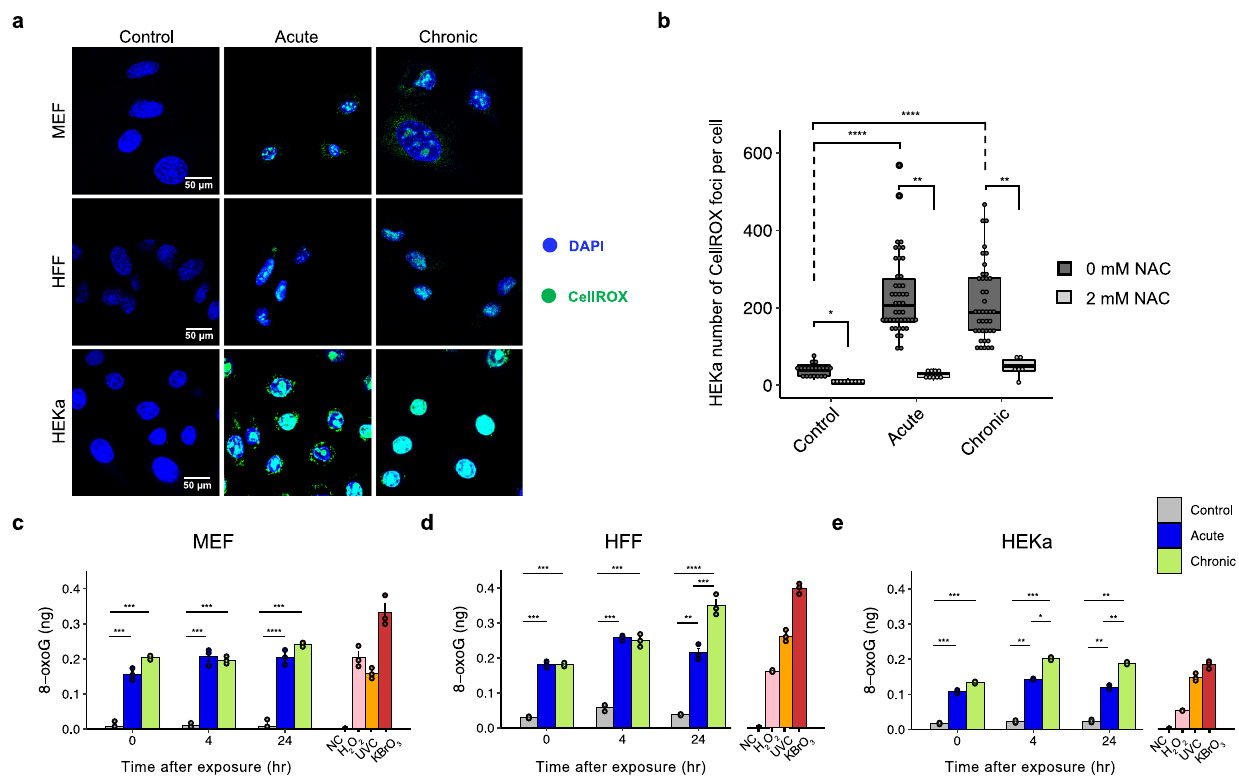
Fig. 3 | Oxidative damage in mammalian cells after irradiation with a UV-nail dryer. a Assessment of oxidative DNA damage by live imaging of CellROX green reagent in control and irradiated MEF (top panel), HFF (middle panel), and HEKa (bottompanel)cells.DAPIisshowninbluewhileCellROXisshowningreen. b HEKa cells were challenged with 2mM N-acetyl-L-cysteine (NAC) for 1hour prior to irra- diation. Quanti fi cation of the number of CellROX foci was performed by analyzing at least 100 cells per condition and comparing cells with and without NAC pre- treatment, collected from triplicates. The bounds of the boxplots represent the interquartile range divided by the median, and Tukey-style whiskers extend to a maximum of 1.5 × interquartile range beyond the box. Oxidative DNA damage